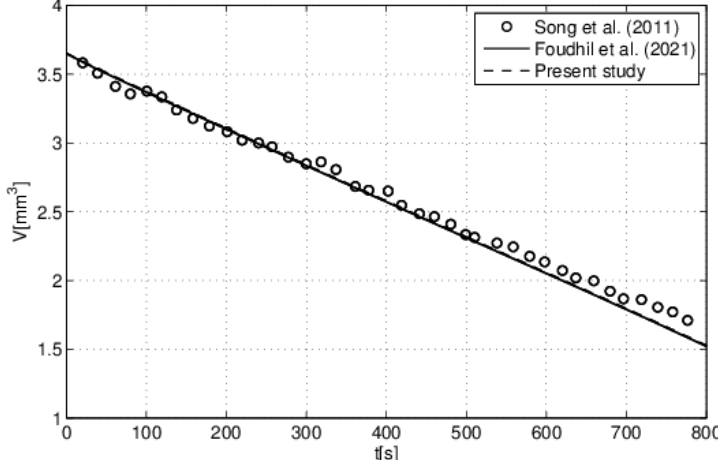
Figure 5. Model validation: volume variation vs. time. Comparison with the numerical study of [31] and the experimental study of [57]. (V 0 = 3.64 mm 3 , θ = 57.2 ◦ , T 0 = 25 ◦ C, H = 40%).